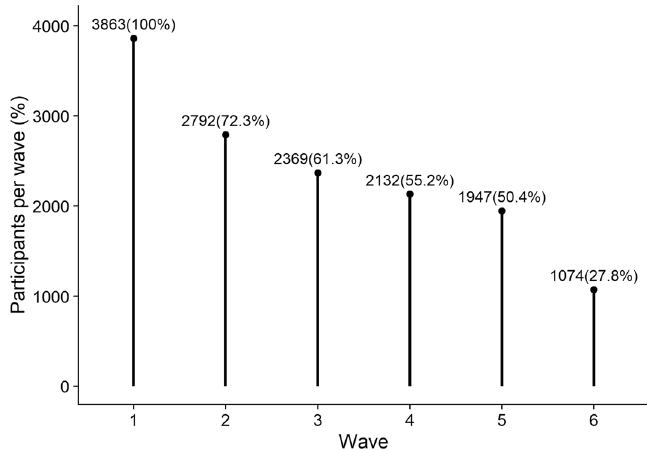
Figure 3. Participants who completed each wave. Participants were the same across waves and were only contacted if they completed the previous wave. In parentheses, we show the attrition